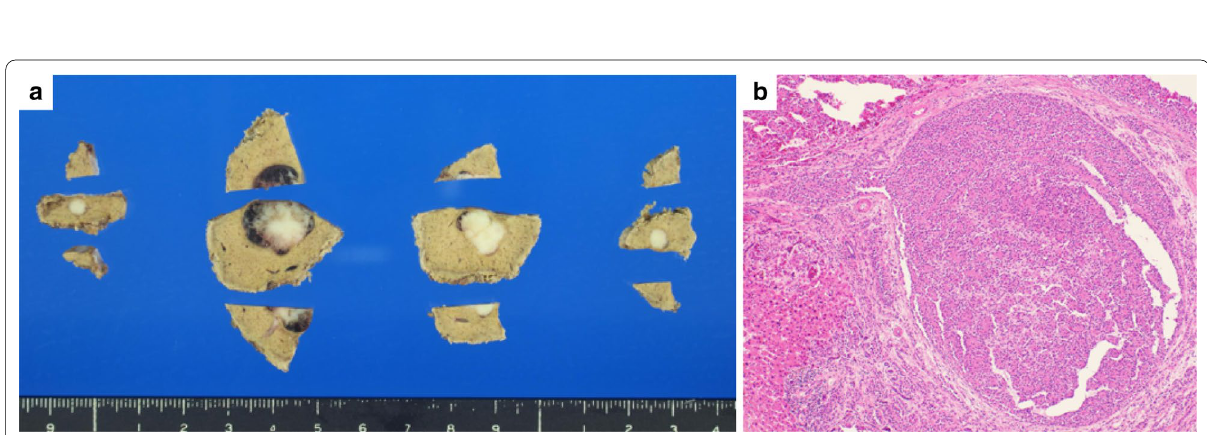
Fig. 2 Gross and histopathological findings of the excised specimens. Left image: gross tumor specimens. Right image: photomicrograph showing eosinophilic tumor cells proliferating throughout. The image shows a pseudopapillary structure centered on a thin vascular connection